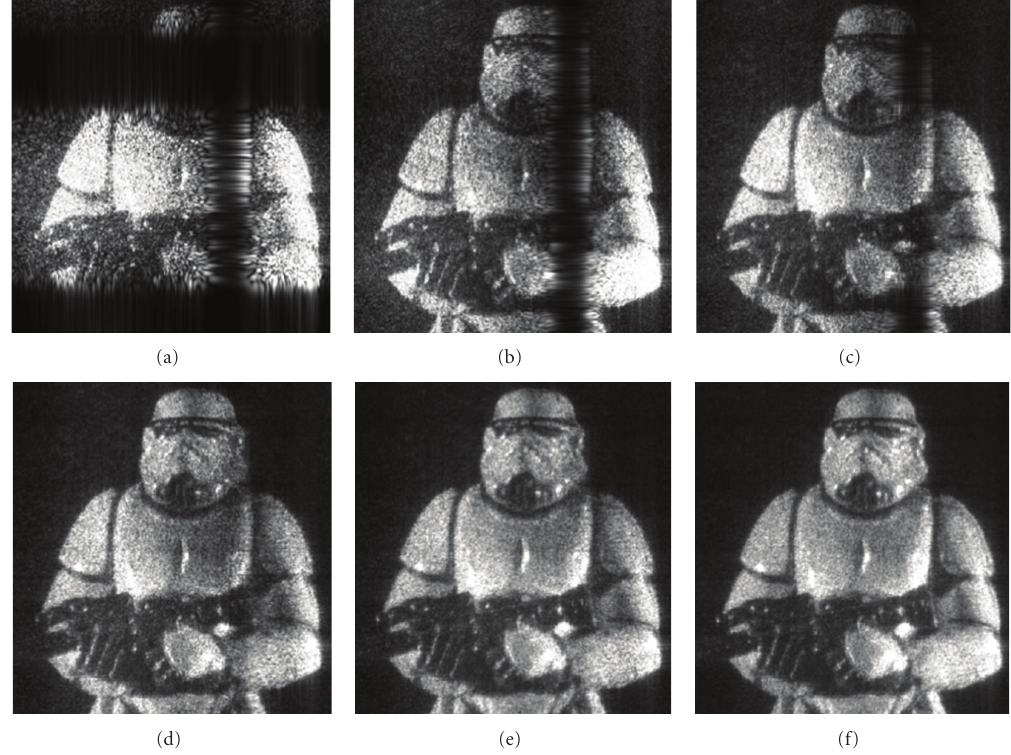
Figure 8: Removal of speckle noise using a numerical technique discussed in the text. We generate 14 di ff erent reconstructions from 1 hologram by filtering in the Fourier domain with a square aperture window of size 128 by 128 pixels. (a) One image, (b) Sum of 3 intensities, (c) Sum of 5 intensities, (d) Sum of 7 intensities, (e) Sum of 10 intensities, (f) Sum of 14